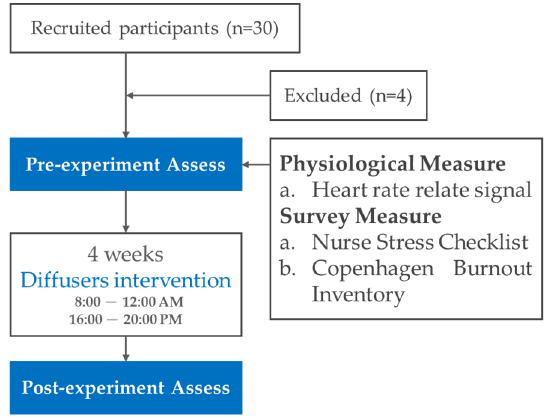
Figure 2. Experiment flow chart.